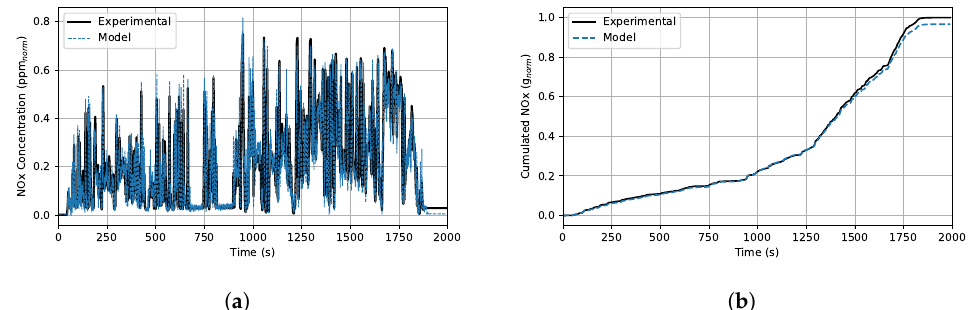
Figure 18. Comparison between experimental and modeled NOx emissions on the first test RDE cycle. ( a ) Instantaneous NOx concentration. ( b ) Cumulated NOx mass. Normalization makes the final experimental value equal to